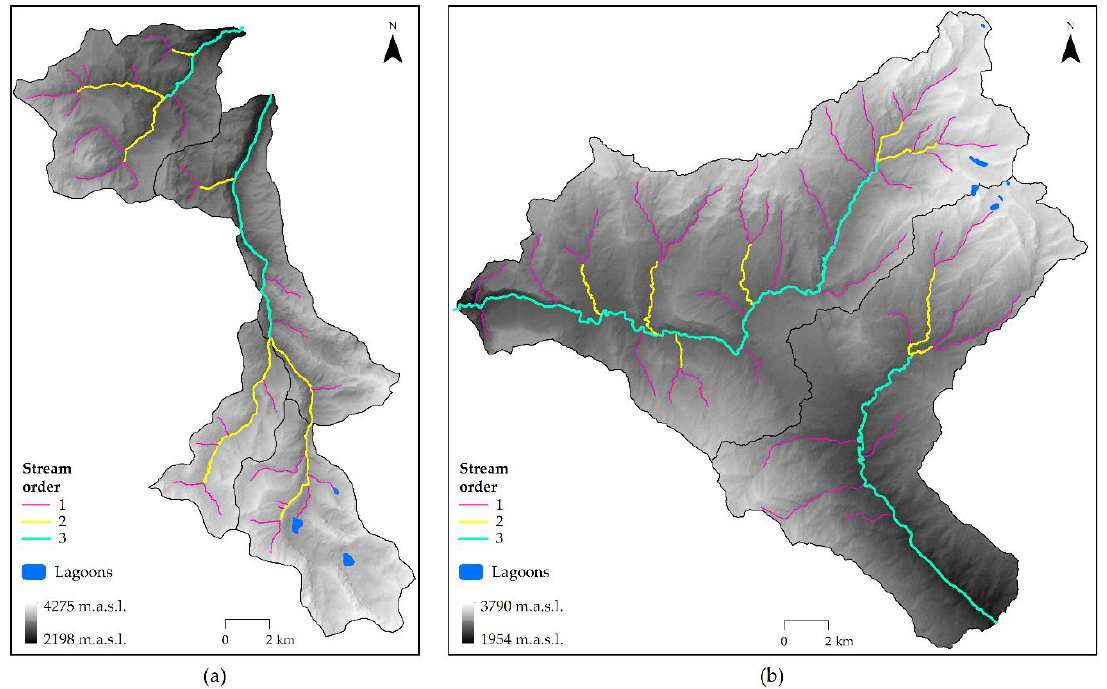
Figure 5. DEM and Stream order ( u ) of the ( a ) four HAL-MWs in Leimebamba and ( b ) two HAL-MWs in Molinopampa (Amazonas,